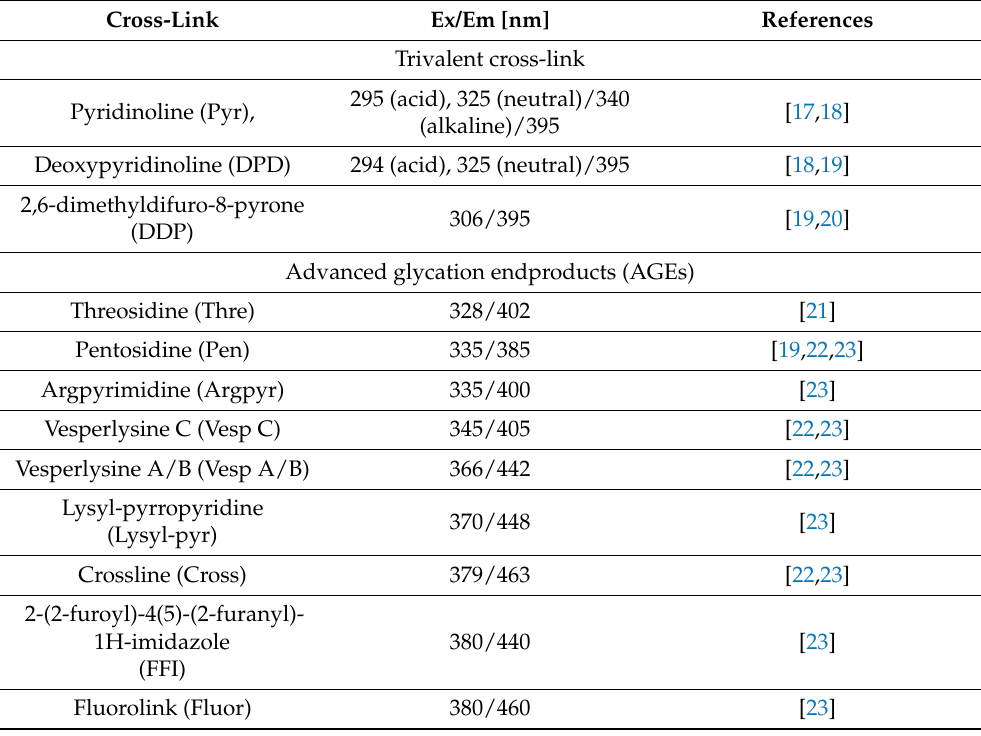
Table 1. The isolated and identified fluorescence-capable cross-links of collagen, together with the wavelengths corresponding to the maxima of fluorescence excitation and emission